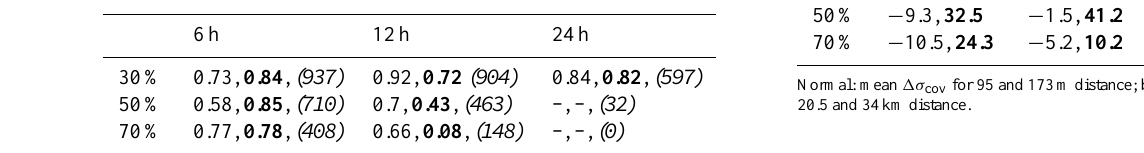
Table A2. R 2 for NEE uncertainty determined with the extended two-tower approach (including sfd-correction and weather filter) as function of NEE corr magnitude and for 20.5km EC tower distance. Results are given for different moving average time intervals (6h, 12h, 24h) and data coverage percentages (25%, 50%, 70%) for the calculation of the sfd-correction factor (Eq. 2).